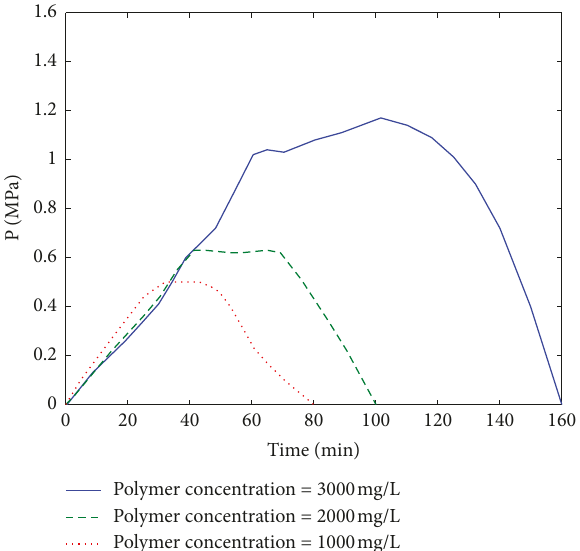
Figure 5: The relationship between pressure and time under different polymer